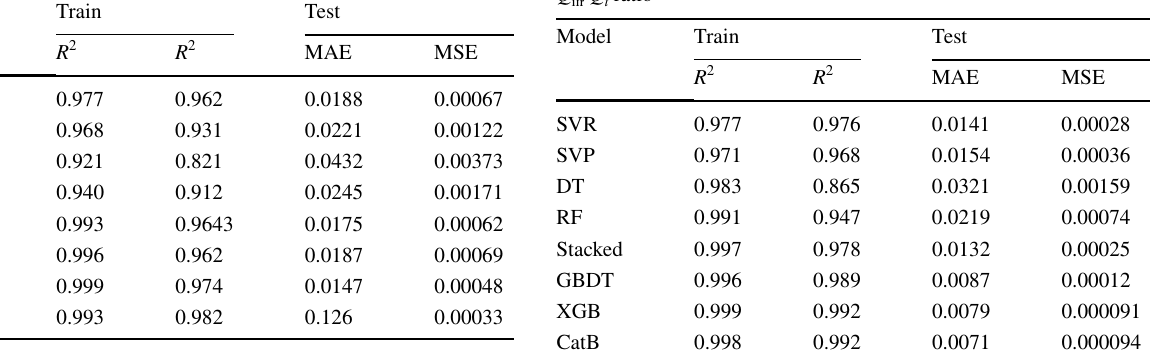
Table 5 Accuracy metrics of different algorithms in the estimation of d